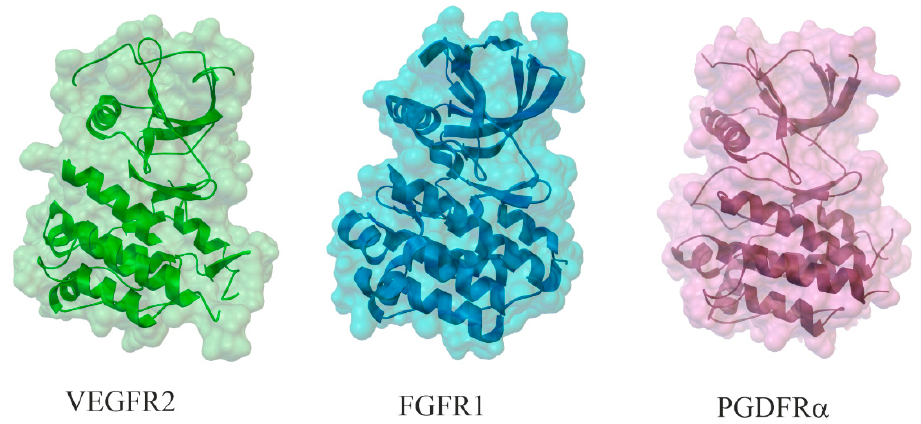
Figure 2. Compression of the selected backbone representation of the crystal structures of the RTK: VEGFR-2 crystal (PDB ID: 3C7Q, 2.10 Å) [21], FGF1 (PDB ID: 1FGK, 2.00 Å) [40], PDGFR α (PDB ID: 6JOL, 1.90 Å) [41].